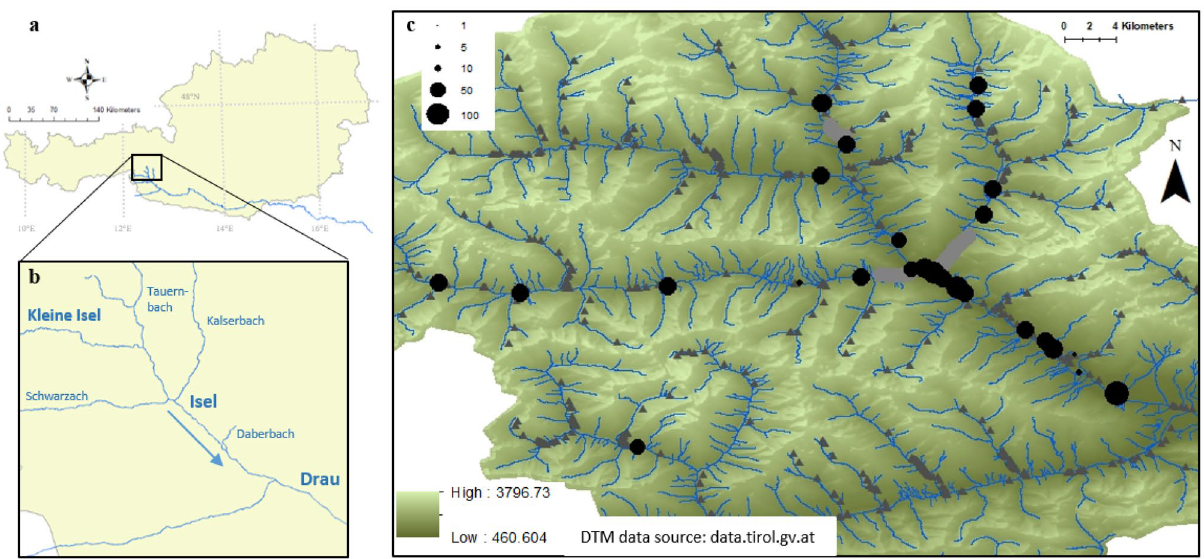
Figure 1. Austria ( a ) with the river Isel and its tributaries in East Tyrol, before they flow into the river Drau ( b ). The sites where Myricaria germanica has been sampled along the Tauernbach, Kleine Isel, Schwarzach, Kalserbach, and Daberbach as well as the populations along Isel are shown ( c ): Populations of different size were sampled (size of black dots representative of number of individuals). The river (blue) and riverscape morphology including canyons (light grey river course), dams and embankments (dark grey triangles), and the digital terrain model (DTM from Land Tirol, data.tirol.gv.at) are shown in the